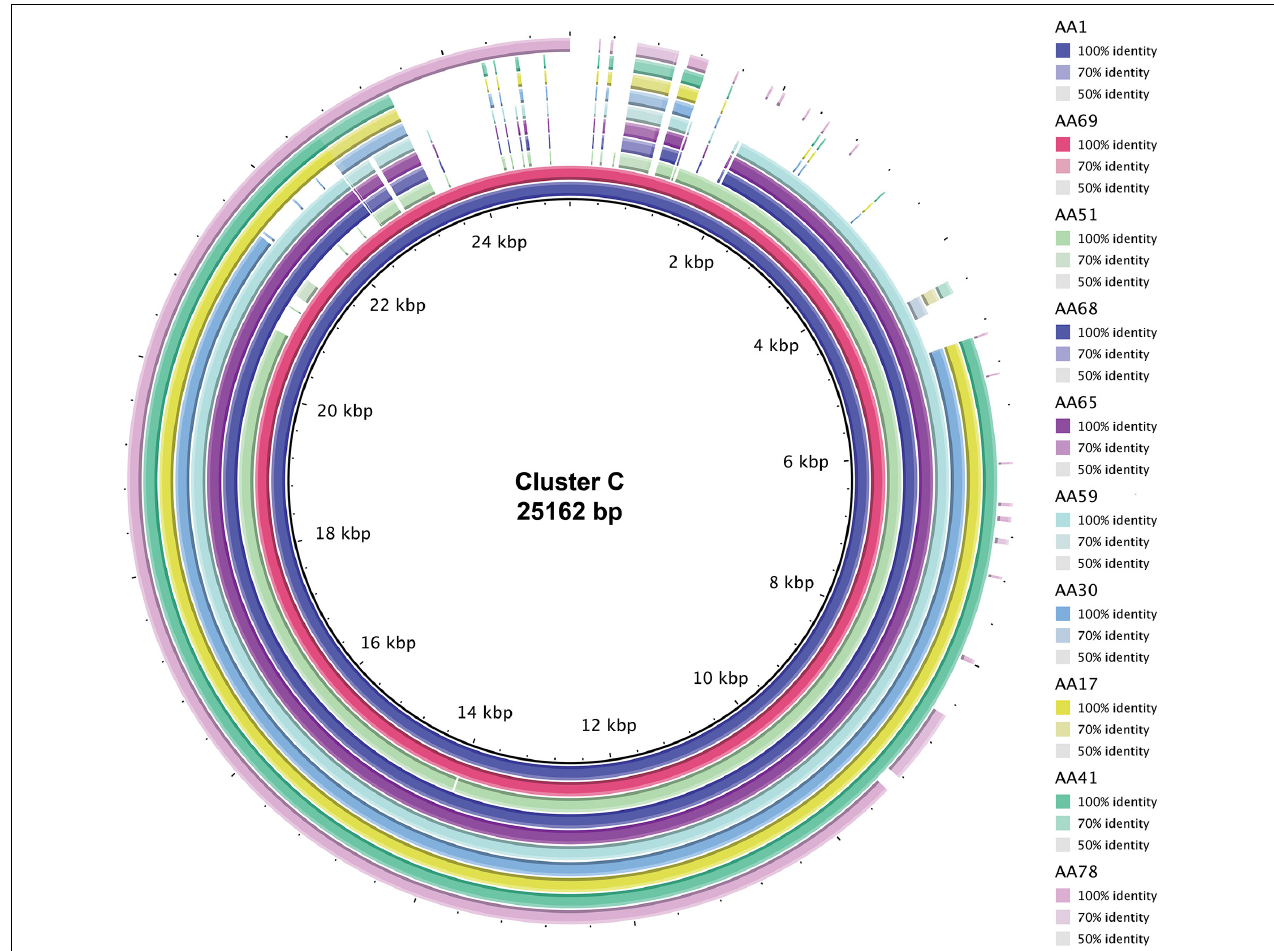
FIGURE 2 | Sequence alignment of the 10 plasmid sequences grouped into Cluster C. The legend indicates the color for the plasmid sequence with the darker tones indicating 100% sequence identity and lighter tones indicative of less sequence identity. Gaps in the alignment signify regions that are not found within the plasmid sequence. The total alignment is 25,162